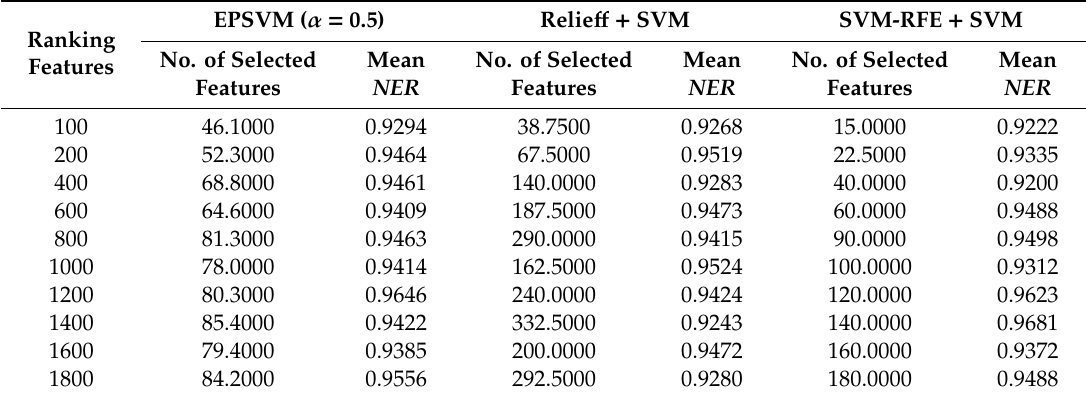
Table 5. NER and feature selection results for dataset 10 (HD + BrCa).